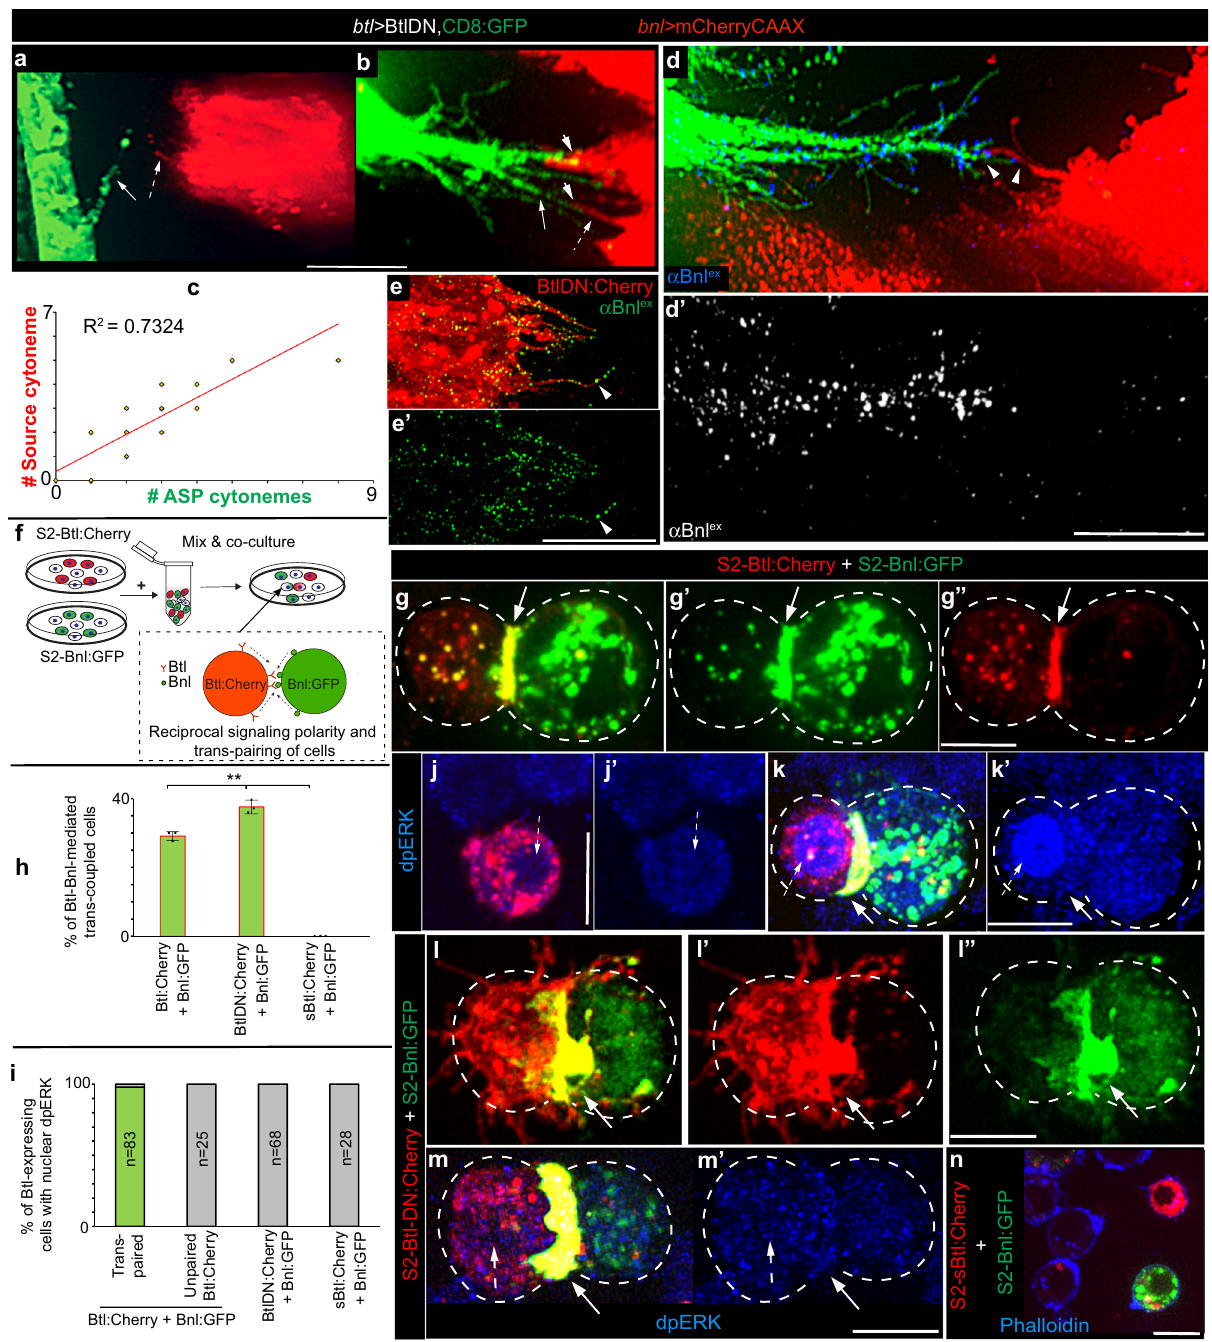
Fig. 3 CAM-like Btl-Bnl interactions produce signaling contacts. a – c Correlation of numbers of polarized Btl-DN-expressing ASP cytonemes (arrow) with the polarized bnl- source cytoneme (dashed arrow) ( btl-Gal4,UAS- CD8GFP/ + ; bnl-LexA,LexO -mCherryCAAX/ UAS - Btl-DN ; see “ Methods ” ); arrowheads, contact sites between ASP and source cytonemes; c, graph showing the correlation between source and ASP cytoneme numbers in each disc ( n = 19). d , d ’ Bnl ex (blue, α Bnl ex ) is asymmetrically enriched at the contact sites (arrowheads) between the source and Btl-DN-expressing ASP cytonemes; d ’ only α Bnl ex channel from d . e , e ’ Btl-DN:Cherry colocalized with Bnl ex (green; α Bnl ex ) on tracheal cytonemes; e ’ only α Bnl ex channel from e . f Drawing illustrating the CAM assay using S2 cells and the binding of cell surface Btl:Cherry and Bnl:GFP that could induce reciprocally polarized synaptic co-clustering of receptors and ligands and trans-pairing of the interacting cells. g – n Trans-pairing of S2-Bnl:GFP with either S2-Btl:Cherry ( g – g ” , k , k ’ ) or S2-Btl-DN:Cherry ( l – m ’ ) but not with S2-sBtl:Cherry control ( n ); dashed lines, cell outline; arrow, trans-synaptic receptor-ligand co-clusters; dashed arrow, nucleus; dpERK (blue, α dpERK). h Bar graphs comparing the mean frequency (±SD) of receptor-ligand trans-pairing from three independent experiments (see “ Methods ” ); p value (**) — p < 0.01 (one-way ANOVA followed by Tukey HSD test); total GFP-positive + mCherry-positive cells analyzed: 1916 (Btl:Cherry +